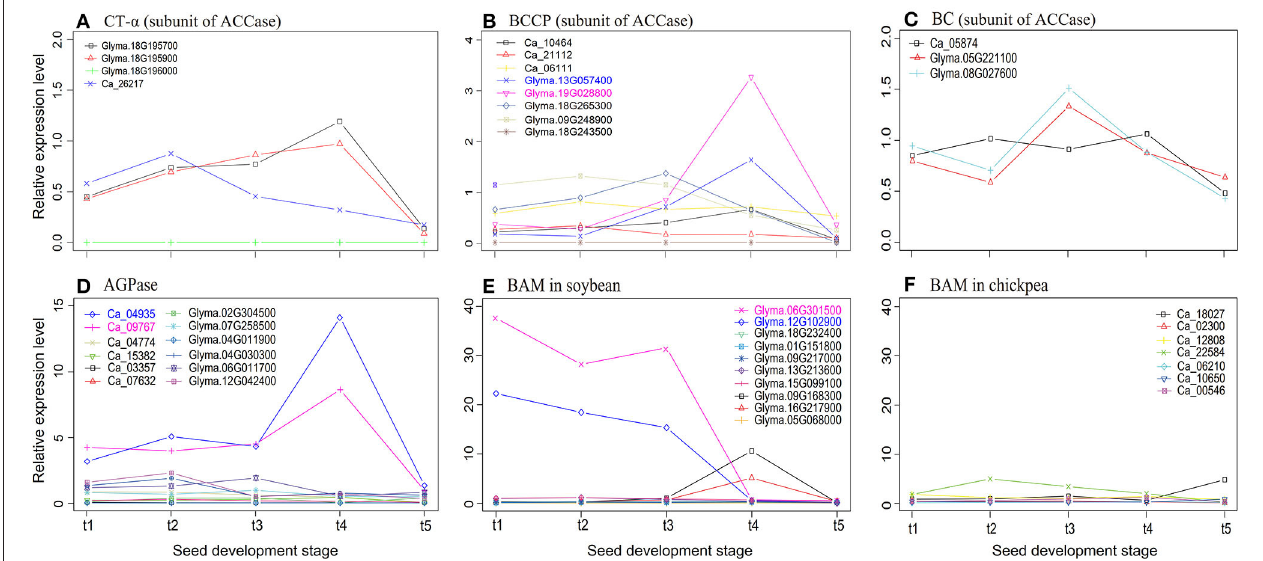
FIGURE 2 | The relative expression levels of three subunits CT- α (A) , BCCP (B) , and BC (C) of ACCase, AGPase (D) , and BAM (E,F) , which are soybean and chickpea common genes, at five seed development stages. The relative expression level was defined by Zhang et al. (2018) as the ratio of the expression level of each gene to the average expression level of all genes in this species. AGPase, ADP-glucose pyrophosphorylase; BC, biotin carboxylase of heteromeric ACCase; BCCP, biotin carboxyl carrier protein; MAB-5, beta-amylase-5.